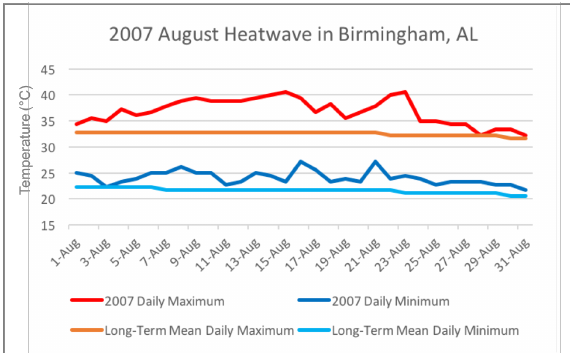
Figure 5. Daily maximum and minimum temperatures of August 2007 in Birmingham, AL, USA in comparison to the long-term mean daily maximum and minimum temperatures of August, in units of ◦ C. The data source is National Weather